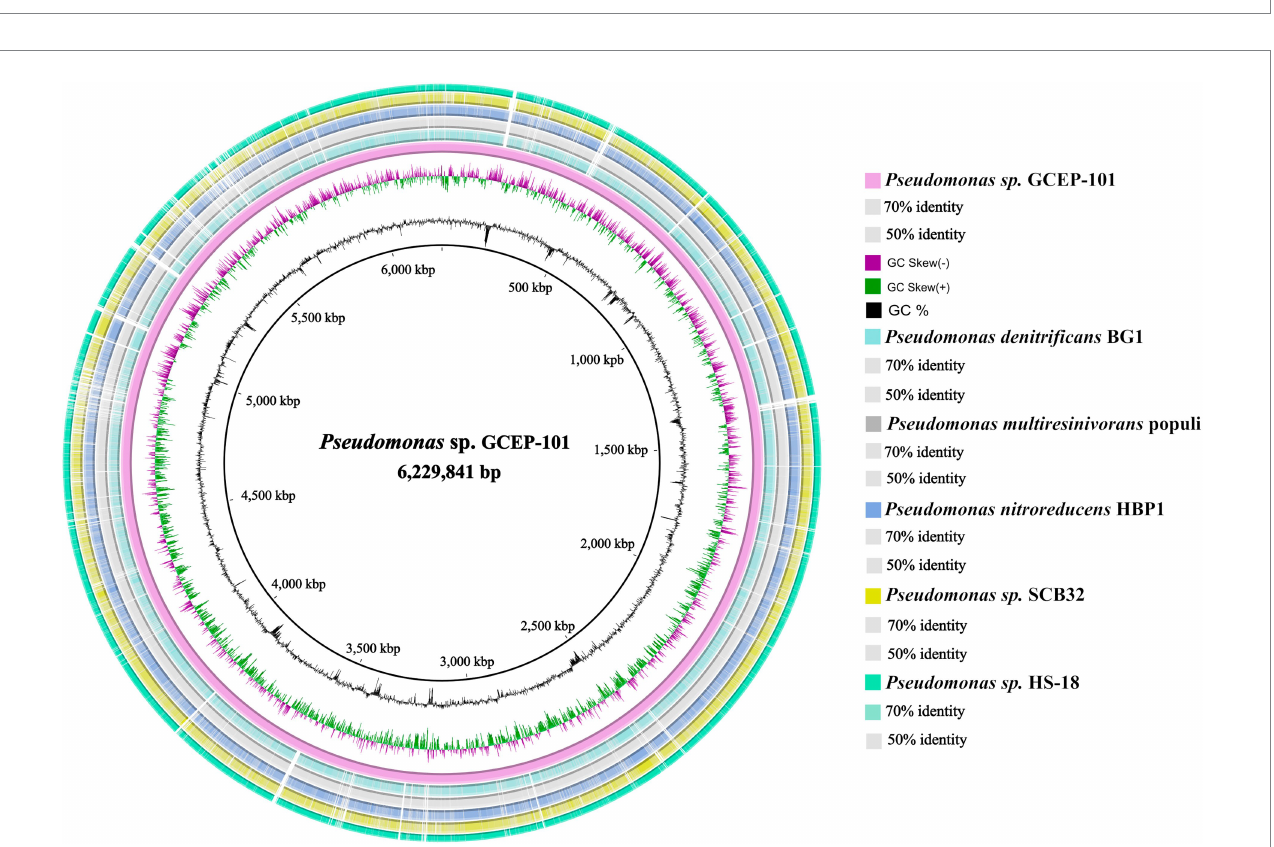
FIGURE 2 Map of the bacterial chromosome of isolate GCEP-101 (purple inner ring). In the five outer concentric rings, the chromosomes of closely related species are aligned. Their nucleotide identities to GCEP-101 are depicted in color gradients. The middle circle indicates de GC skew [(G − C)/(G + C)] positive (green) and negative (purple). The inner most circle (black) indicates the % GC content.